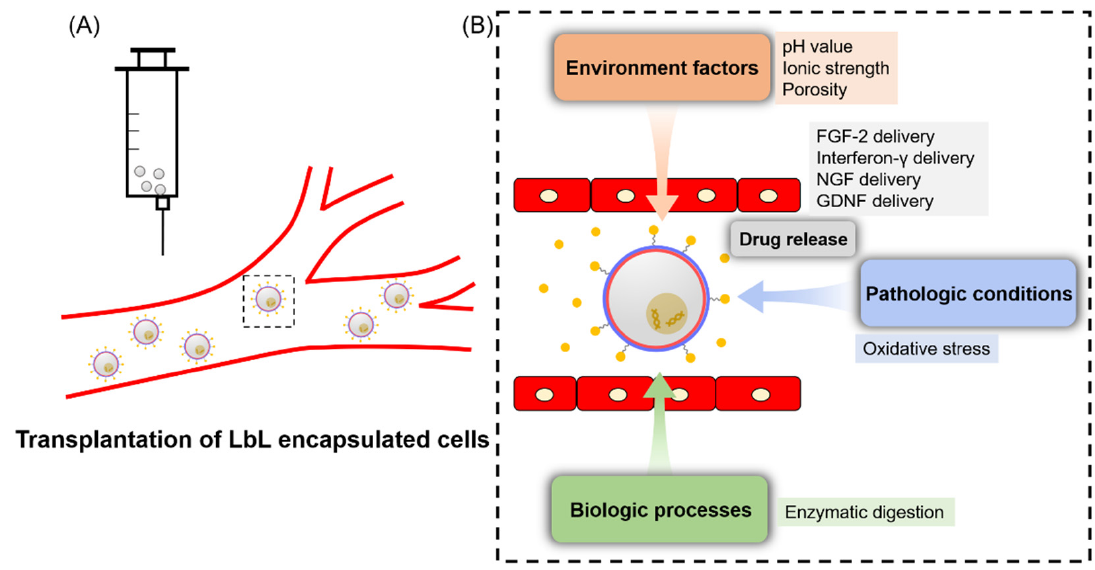
Figure 5. LbL cell encapsulation for drug delivery can be tuned by multiple factors. ( A ) This technique can be applied in cell transplantation therapy for various diseases. ( B ) Drug delivery is able to be manipulated by different factors and representative works are listed.